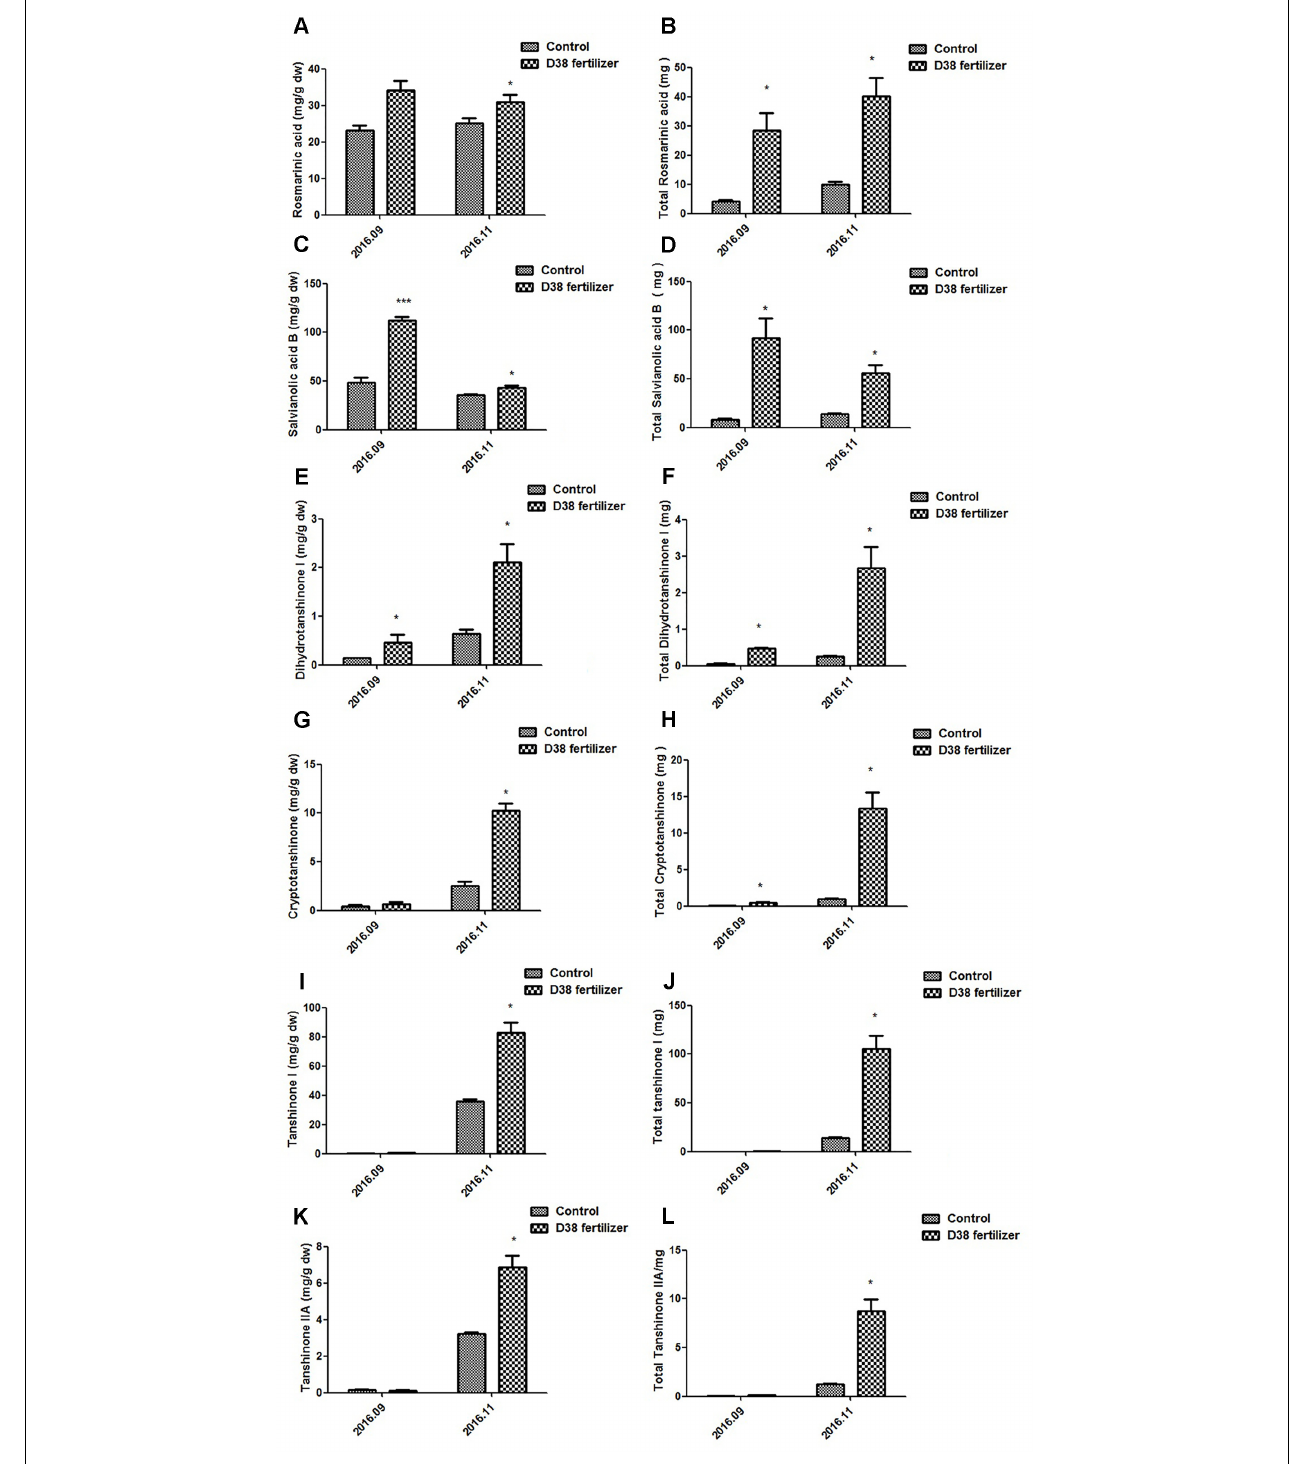
FIGURE 8 | Contents of bioactive substances in S. miltiorrhiza root under the treatment of 20 g D38 fertilizer compared with untreated group from September 2016 to December 2016. (A) Rosmarinic content per unit of root mass; (B) Total rosmarinic content; (C) Salvianolic acid B content per unit of root mass; (D) Total salvianolic acid B content; (E) Dihydrotanshinone I content per unit of root mass; (F) Total dihydrotanshinone I content; (G) Cryptotanshinone content per unit of root mass; (H) Total cryptotanshinone content; (I) Tanshinone I content per unit of root mass; (J) Total tanshinone I content; (K) Tanshinone IIA content per unit of root mass; (L) Total tanshinone IIA